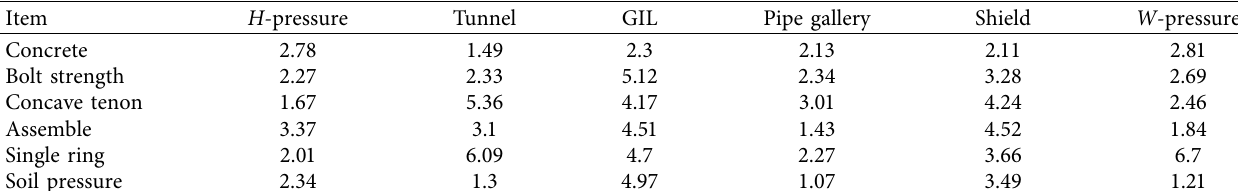
Table 1: Failure characteristics of single- and combined-ring segment structures of two tunnels.